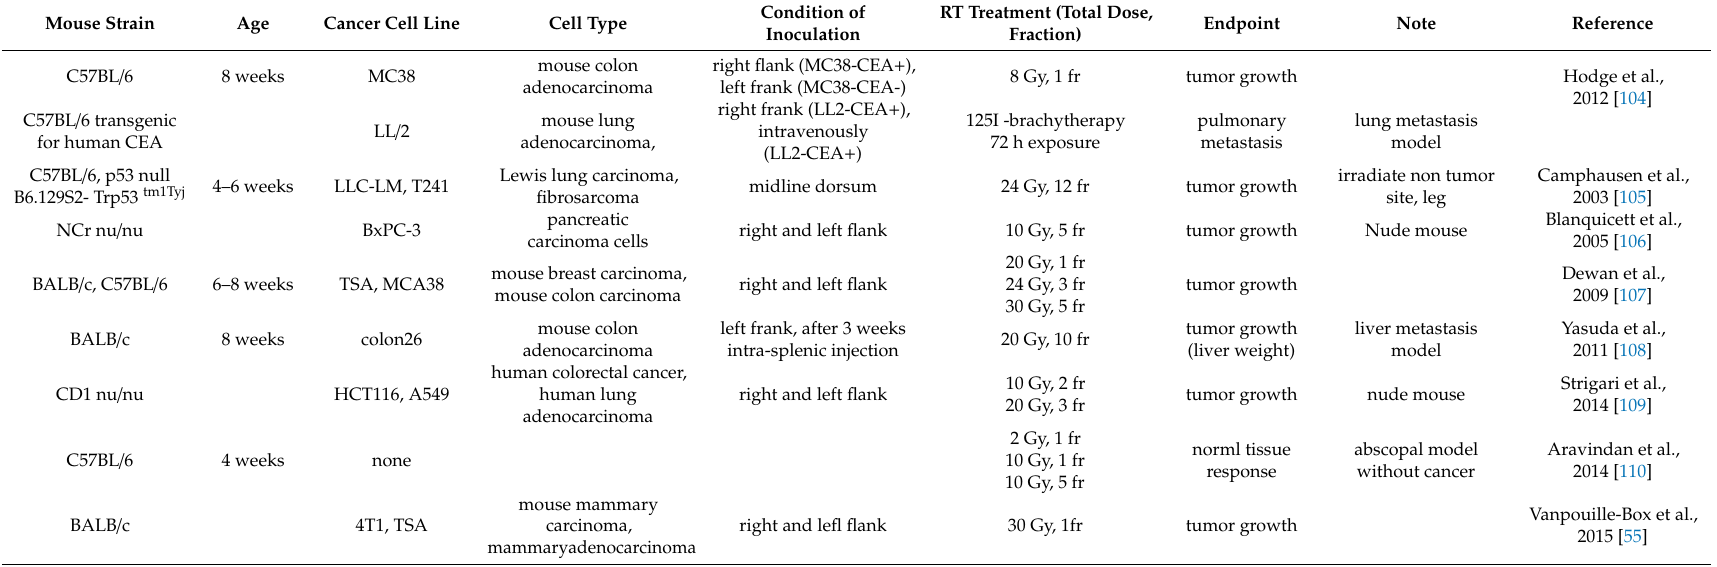
Table 2. Animal models used in past studies for evaluating abscopal e ff